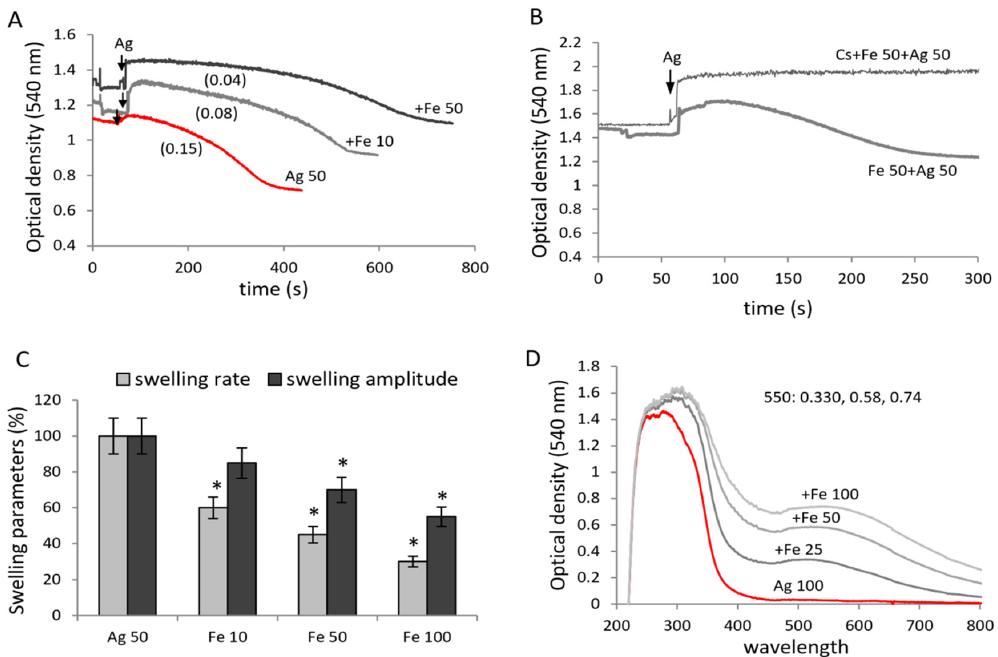
Figure 6. Influence of agrimoniin on the mitochondrial swelling in the presence of iron ions. Swelling of mitochondria induced by agrimoniin (50 µM) in the presence of 10 µM and 50 µM FeSO 4 ( A ); inhibition of swelling induced by agrimoniin + iron ( B ); swelling rates ( Δ D/min) and swelling amplitude ( Δ D) during the combined additions of 50 µM agrimoniin and iron ions at different concentrations ( C ); changes in spectral characteristics of agrimoniin after addition of iron ( D ). Swelling rates ( Δ D/min) are indicated in parentheses. Asterisk (*) indicates values that differ significantly from the control values ( p < 0.05).